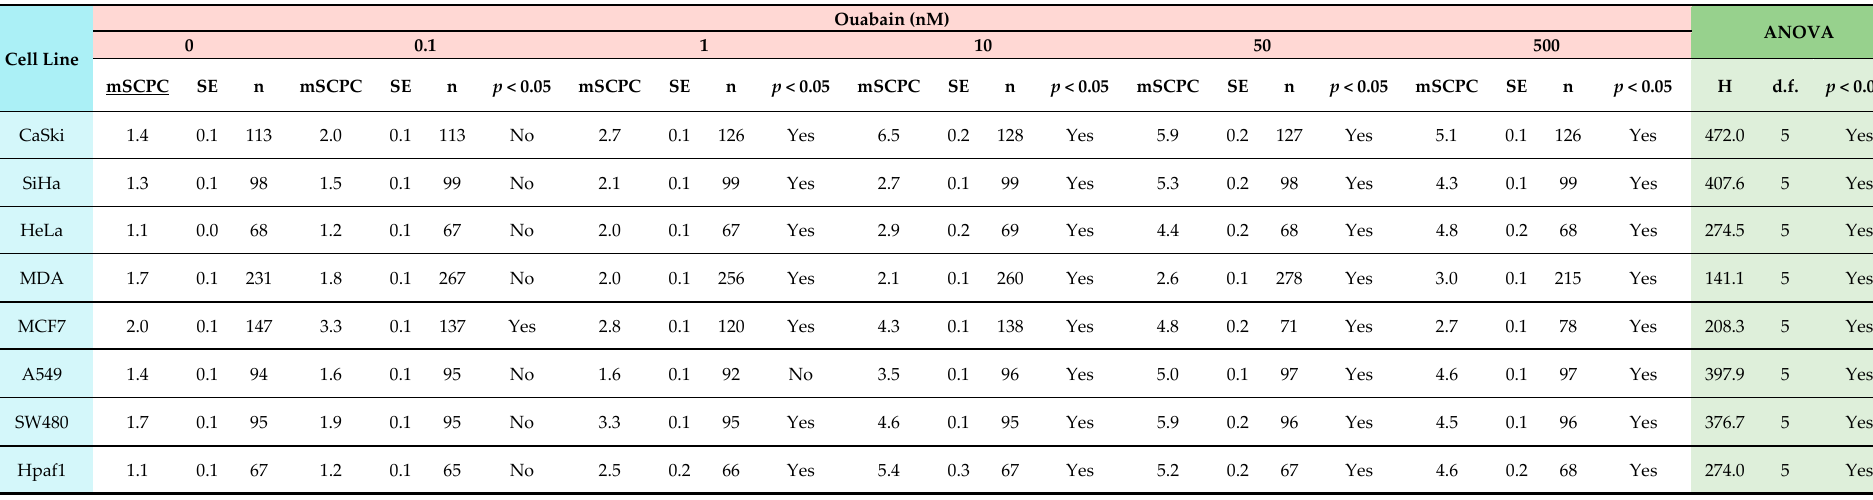
Table 1. Statistical analysis of the effect of ouabain on cancer lines. The columns below the pink panel show, for each concentration tested: The mSCPC, standard error, number of repeats and the result of a paired comparison vs. control ( p < 0.05). The green part shows the result of an ANOVA (Kruskal–Wallis) test, the H value, degrees of freedom, and whether or not it is statistically significant ( p < 0.001).